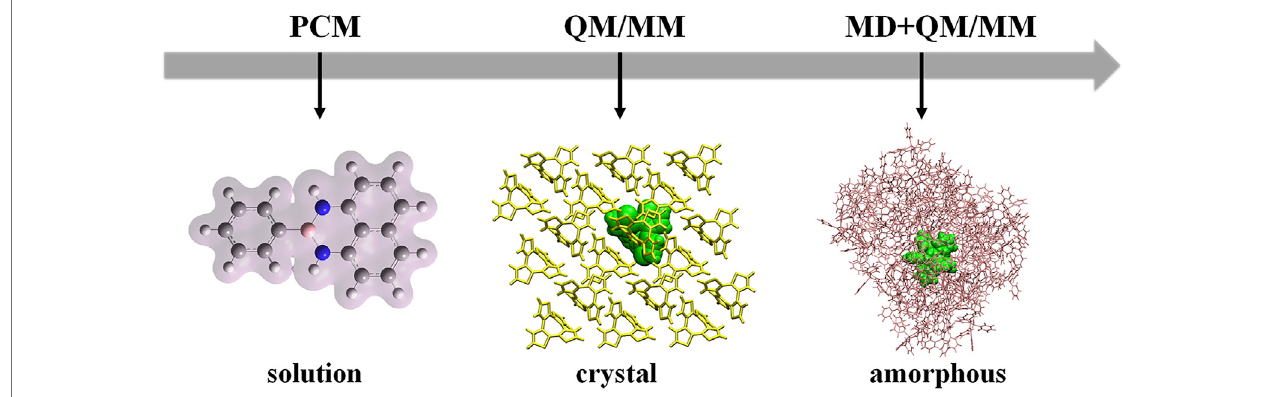
FIGURE 1 | Setup models of organic molecules in dilute solution, crystal, and amorphous